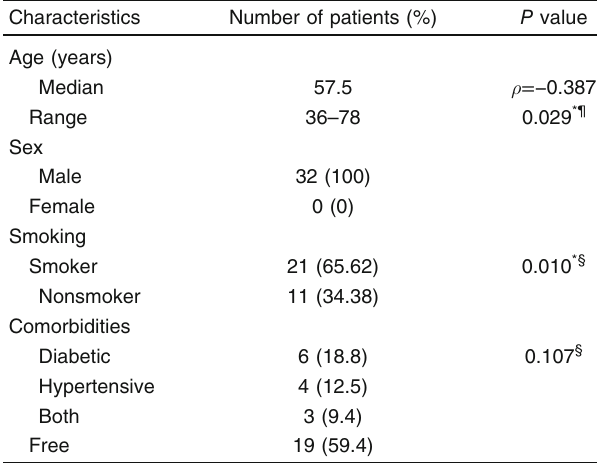
Table 1 General subject characteristics and its association with postoperative aspiration